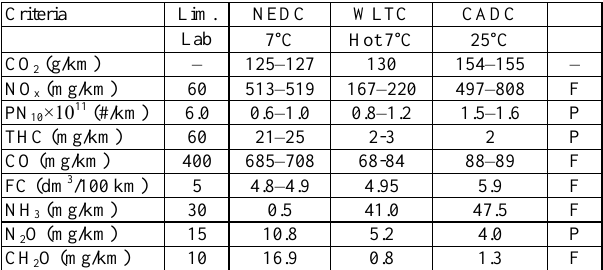
Table 4. Emissions measured by JRC for the cycles prescribed in the prize rules. F = Fail, P = Pass based on the Engine limits because the prototype vehicle was delivered for the Engine prize (Table 1). Lim. =